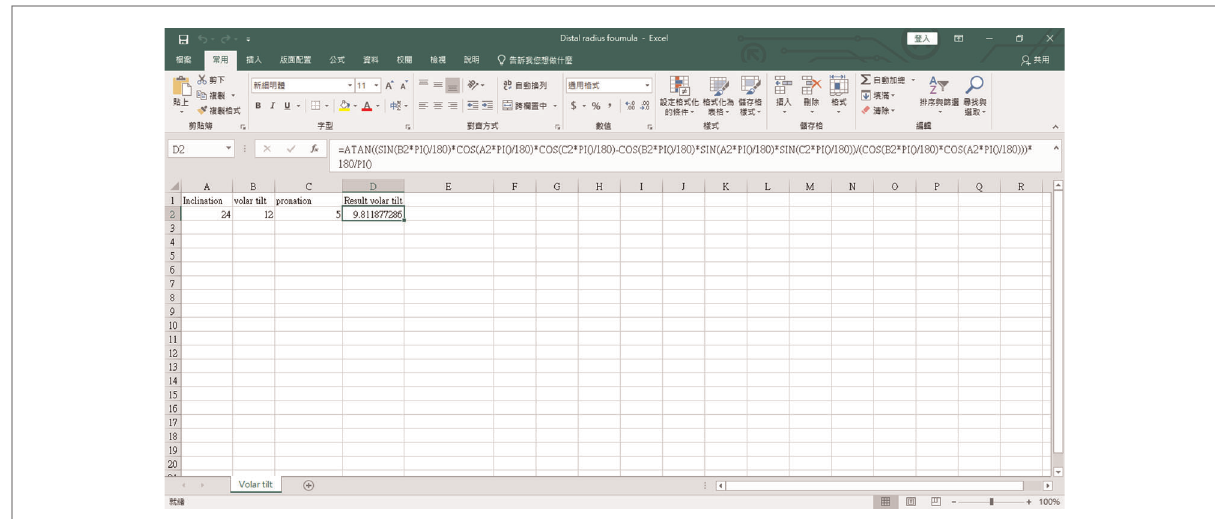
FIGURE 3 The excel program for the mathematical formula. The source code is as follows: “ =ATAN((SIN(B2*PI()/180)*COS(A2*PI()/180)*COS(C2*PI()/180)-COS (B2*PI()/180)*SIN(A2*PI()/180)*SIN(C2*PI()/180))/(COS(B2*PI()/180)*COS(A2*PI()/180)))*180/PI() ” . Readers can copy and paste the code